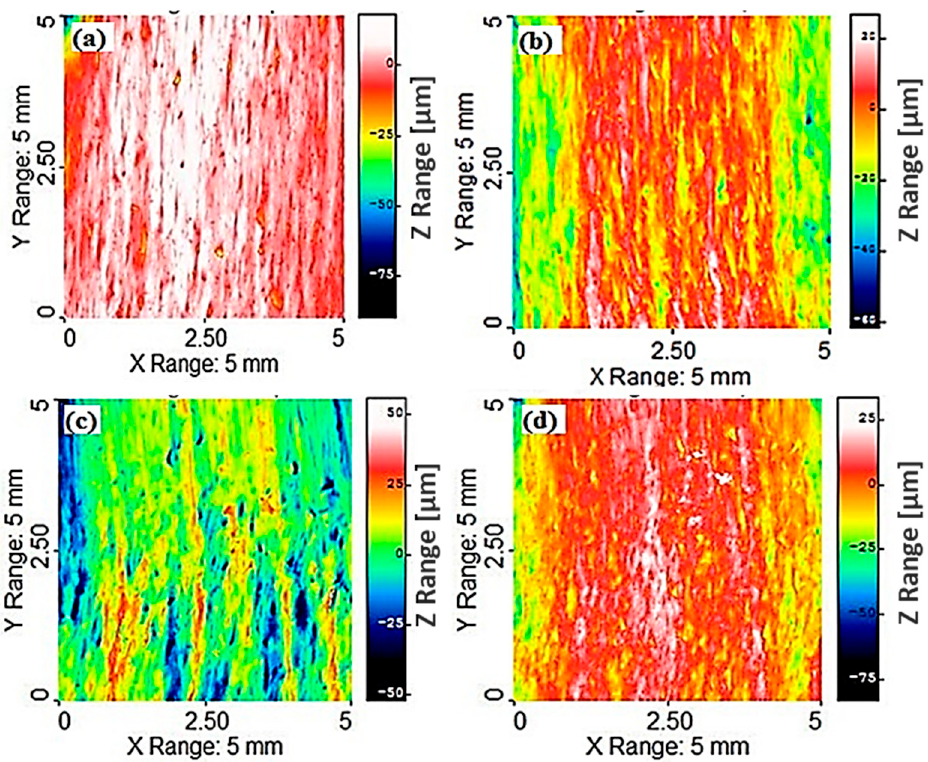
Figure 3. Surface topographical image of sample ( a ) B1; ( b ) B2; ( c ) B3; ( d ) B4 after experiment. The machined surfaces of Mg-6Al/0.66 Al 2 O 3 contain pronounced ploughing traces generated by abrasive grains, as shown in Figure 4. These traces are formed due to the interaction of the grains with the material. The grains plough the ductile material, leading to material disintegration. The ridges of the traces are very closely positioned and sharp when the traverse speed is lower (20 mm/min) (Figure 4a). At a slightly higher speed (250 mm/min), there are small oval depressions sparsely dispersed on the surface (Figure 4b). The ridges flatten and the distance between traces increases with the increase in traverse speed (500 mm/min) due to decreased interaction time between the abrasive grains and the material surface (Figure 4c). A very irregular surface with randomly oriented traces is generated when the traverse speed (40 mm/min), abrasive rate (200 g/min) and jet pressure (100 MPa) are low, as shown in Figure 4d.